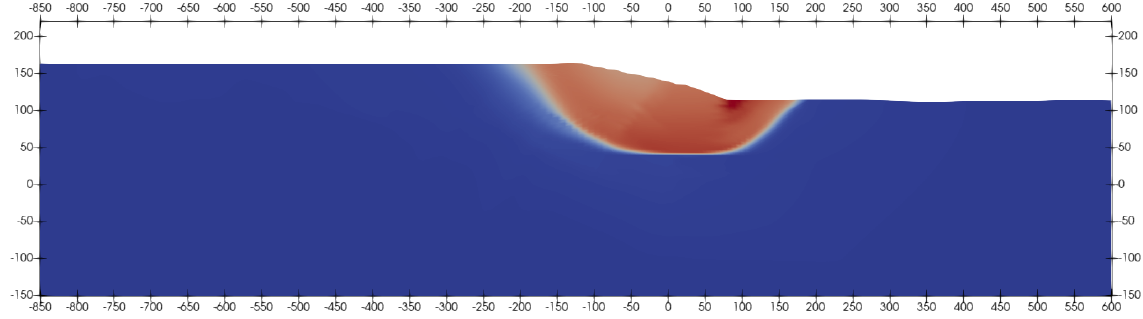
Figure 17: Failure surface at step 170 for dataset IV.